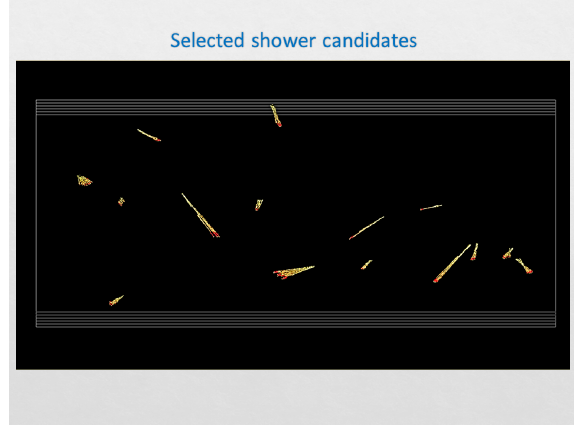
Fig 10. 3D display of selected shower candidates in plates from #5 to #10 in zone = 5 (13cm module, they are more likely to be hadronic showers or interac-